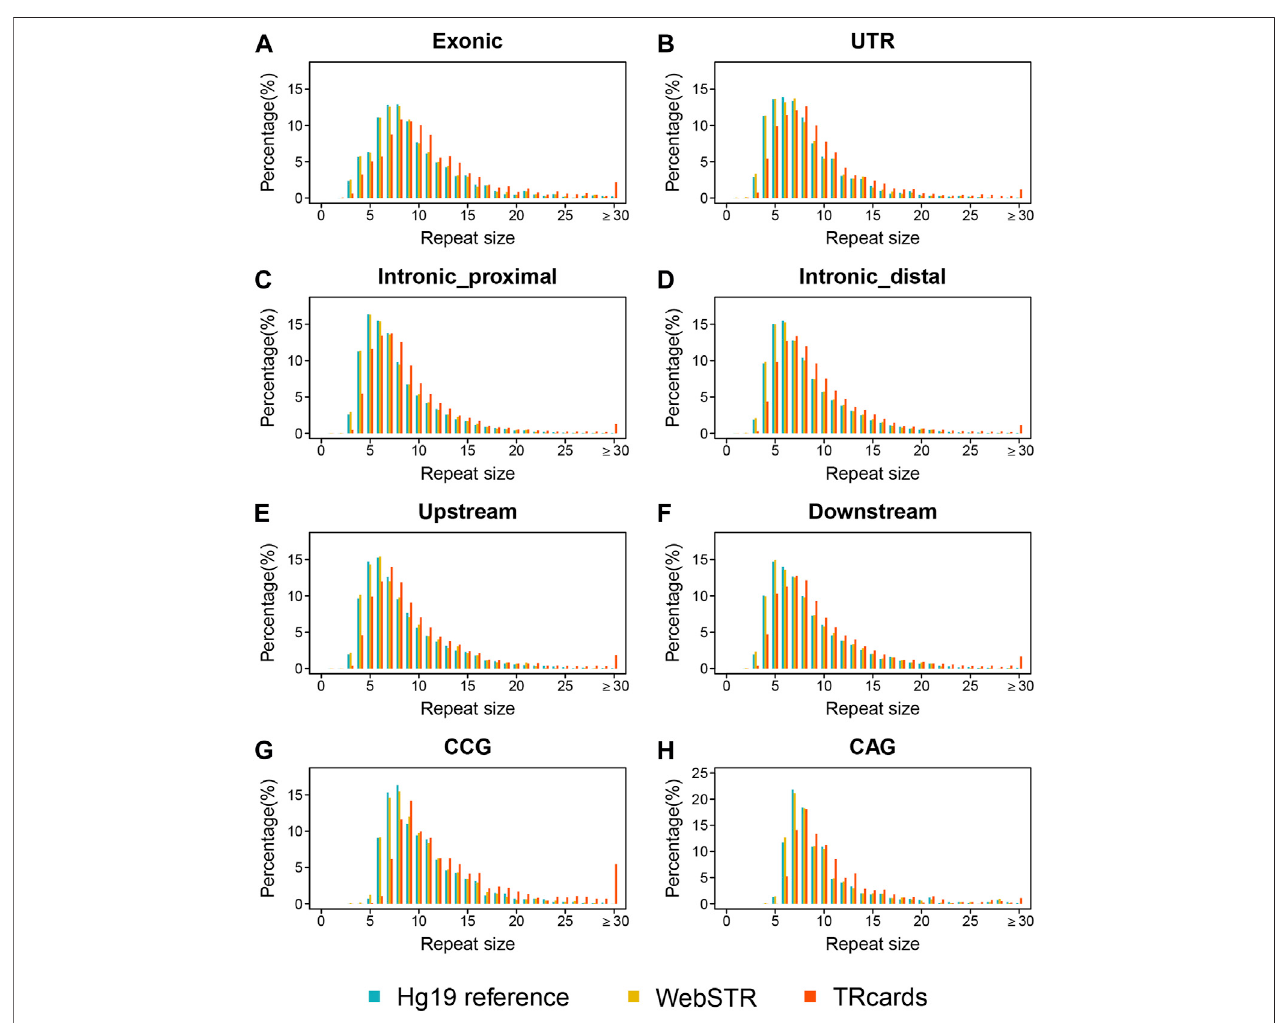
FIGURE 1 | Genome-wide pro fi ling of STR compared with published databases. (A – F) Distribution of repeat sizes in TRcards, Hg19 reference, and WebSTR databasebystratifyingSTRaccordingtogenomicfeatures,includingtheexonicregion (A) ,theuntranslated region(UTR) (B) ,theintronicproximalregion(de fi nedasthe location within 1 kb from the nearby gene) (C) , the distal region of the intron (de fi ned as a location more than 1 kb away from the nearby gene), the upstream region (E) , andthedownstreamregion (F) . (G – H) DistributionofrepeatsizesforCCGunit (G) andCAGunits (H) inTRcards,WebSTR,andHg19referencedatabase.Repeat unitCCGandrepeatunitCAGarecommonSTRrepeatunitsreportedtocausegeneticdiseases.Inallpanels,blue=Hg19reference;yellow=WebSTR;red=TRcards (our dataset). The x -axis shows the repeat size (repeat sizes above 30 are combined together). The y -axis shows the percentage of total STR